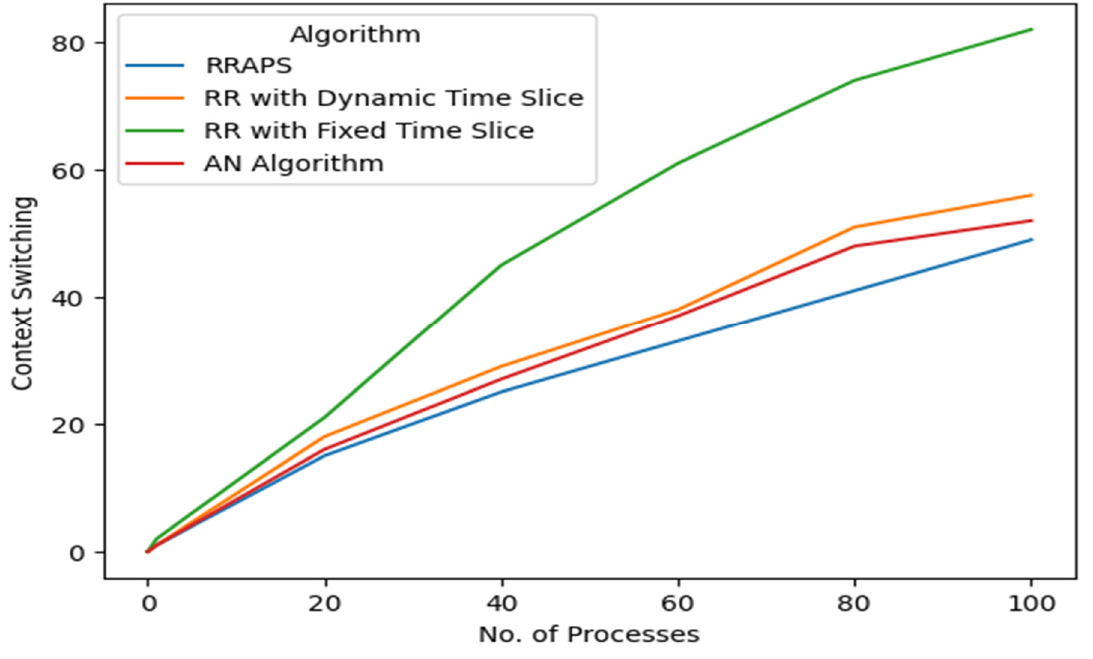
Figure 4. Comparison of context switching between algorithms for 100 processes.